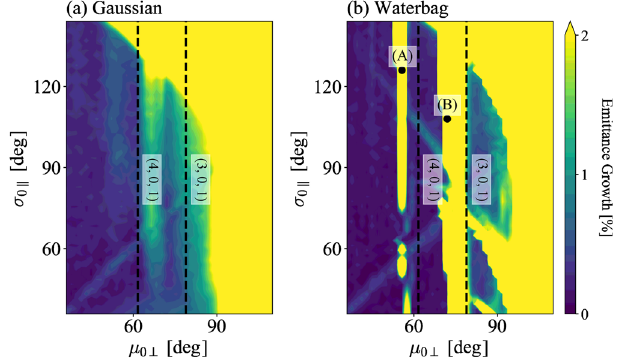
injection.FIG. 5. W ARP simulation results obtained with (a) the Gaussian beam and (b) the waterbag beam. The emittance growth is evaluated at the exit of the 100th AG cell. The initial value of η ⊥ is fixed at 0.7 everywhere. The transverse rms emittance also maintained in both cases, but the longitudinal parameters η k and ε k are determined at each operating point so as to meet the equipartitioning condition. The locations of the noncoupling sextupole ( m ¼ 3 ) and octupole ( m ¼ 4 ) resonances expected from Eq. (6) with C 3 ¼ 0 . 8 and C 4 ¼ 0 . 9 are indicated by dashed lines. Three numbers in the picture represent ð n ⊥ ; n k ; n 0 Þ . The phase-space distributions of the waterbag beam at the operating points (A) and (B) are exhibited in Fig.